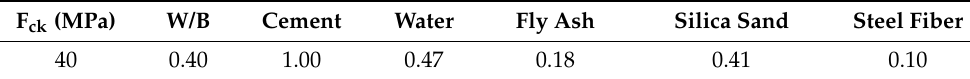
Figure 2. Contents of the test environment for measuring the deformation of the specimen and the discoloration response of the mechanochromic sensor. ( a ) Environment and method for attaching mechanochromic sensor; ( b ) stress concentration zone and setting for video recording.